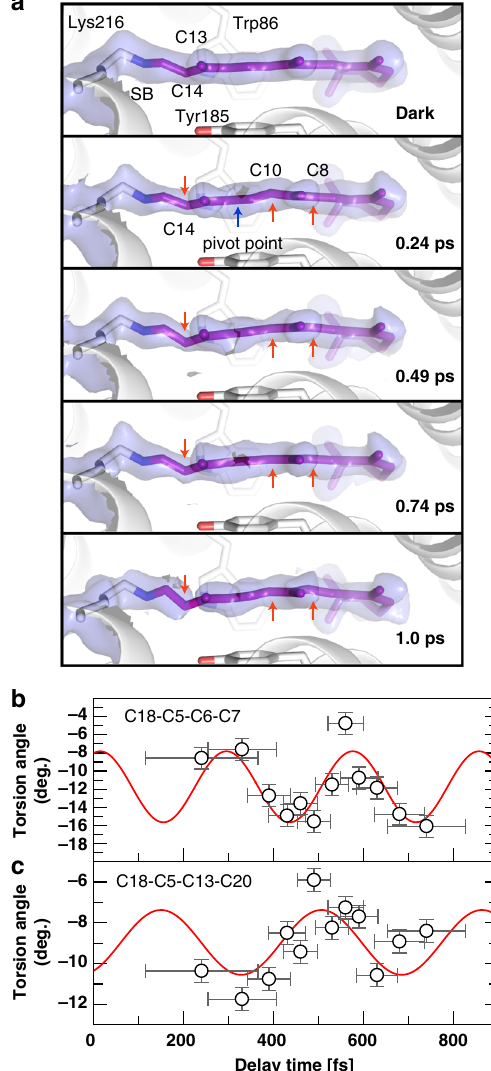
Fig. 6 Sub-ps effects of photon absorption on retinal. a Close-up of the retinal (purple sticks) in the dark-unrestrained state, as well as at 0.24, 0.49, 0.74 and 1 ps. Distortions from the initial planarity of the retinal occur within 0.24 ps and evolve further in time, especially at the Schiff base bond, at the C13 = C14 bond and at the C10-C11 bond, while the C10 and C14 atoms move in opposite directions (red arrows, a blue arrow marks the pivot point) away and towards Tyr185 (shown as sticks), respectively. Minor torsion occurs also at C8. The electron density maps around the retinal (re fi ned for the dark state, 15% extrapolated for the other panels) are contoured at 1.0 σ . At 1 ps, the density for the C13 = C14 bond is only visible at lower contour levels. b , c , The torsion angles between the β -ionone ring and the beginning (C18-C5 = C6-C7 torsion angle, b ) and end (C18-C5-C13-C20 torsion angle, c ) of the polyene chain are plotted in time. The oscillatory modulation of the angles with frequencies of 119 ± -9 cm − 1 ( b ) and 93 ± 14 cm − 1 ( c ) further visualize the twisting of the entire retinal. The error bars were derived as described in the Supplementary Methods. Source data are provided for Fig. 6b, c as a Source Data fi 0.24 ps, the C9 = C10 bond also distorts and undulates on the sub- ps timescale, while the C13 = C14 bond torsion mostly progresses. The largest displacements, in opposite directions, are at atoms C14 and C10, while C8 undergoes minor distortion in the same direction as C10. Like all other features describing the